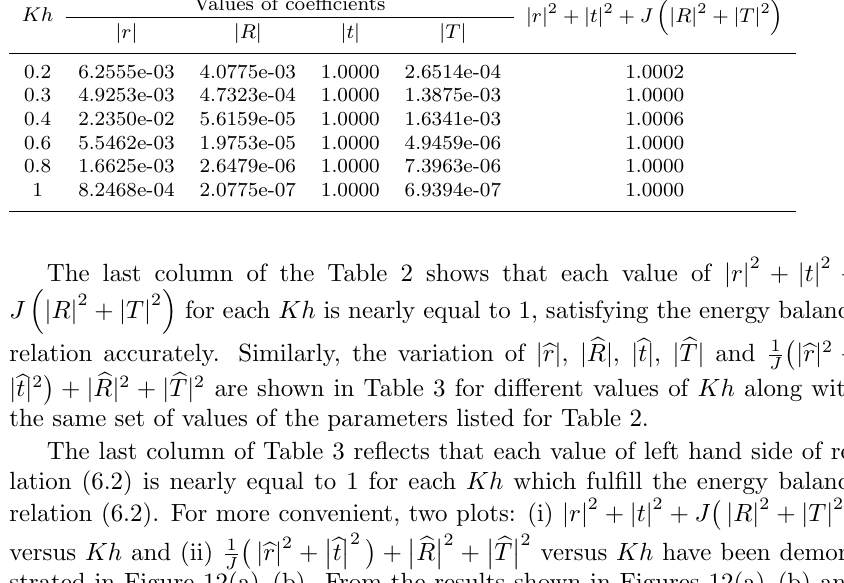
Table 2. Values of all coefficients for energy identity relation (6.1) Values of Kh